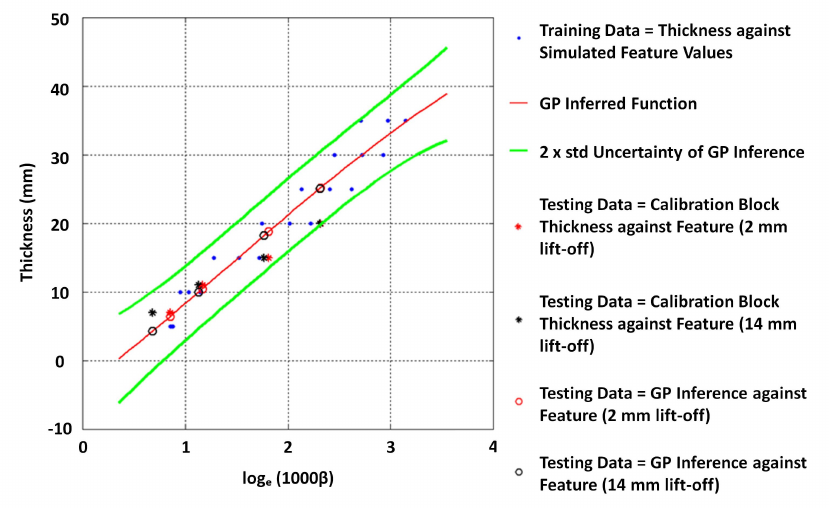
Figure 24. A GP modelled function usable to infer the unknown thickness from β with a considerable uncertainty.